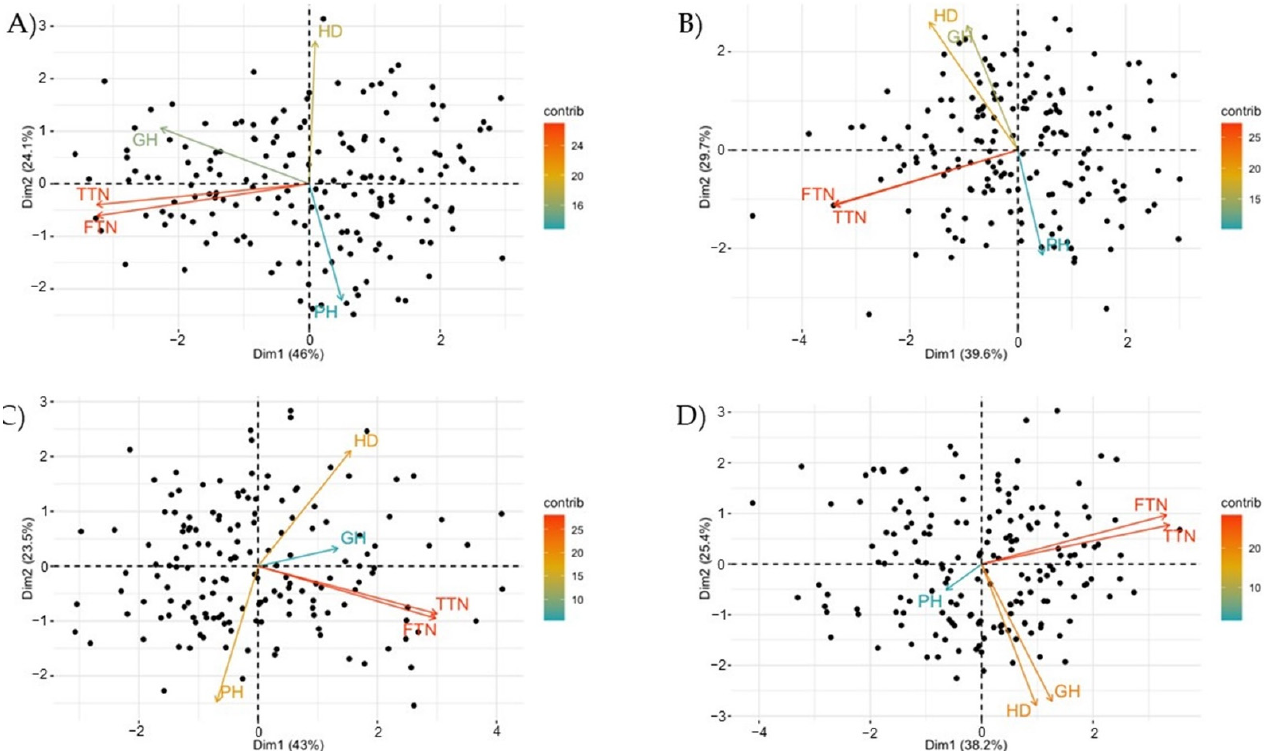
Figure 1. Principal component analysis (PCA) diagram showing the phenotypic variation and variable contribution in F 2 ( A ), F 3 ( B ), F 6 ( C ), and F 7 ( D ) generations. Black points correspond to genotypes, whereas the arrows represent the contribution of the variables to the total variation. HD, heading date; PH, plant height; GH, growth habit; TTN, total tiller number; FTN, fertile tiller number; contrib, contribution of variables to the principal axes expressed as a percentage (%).